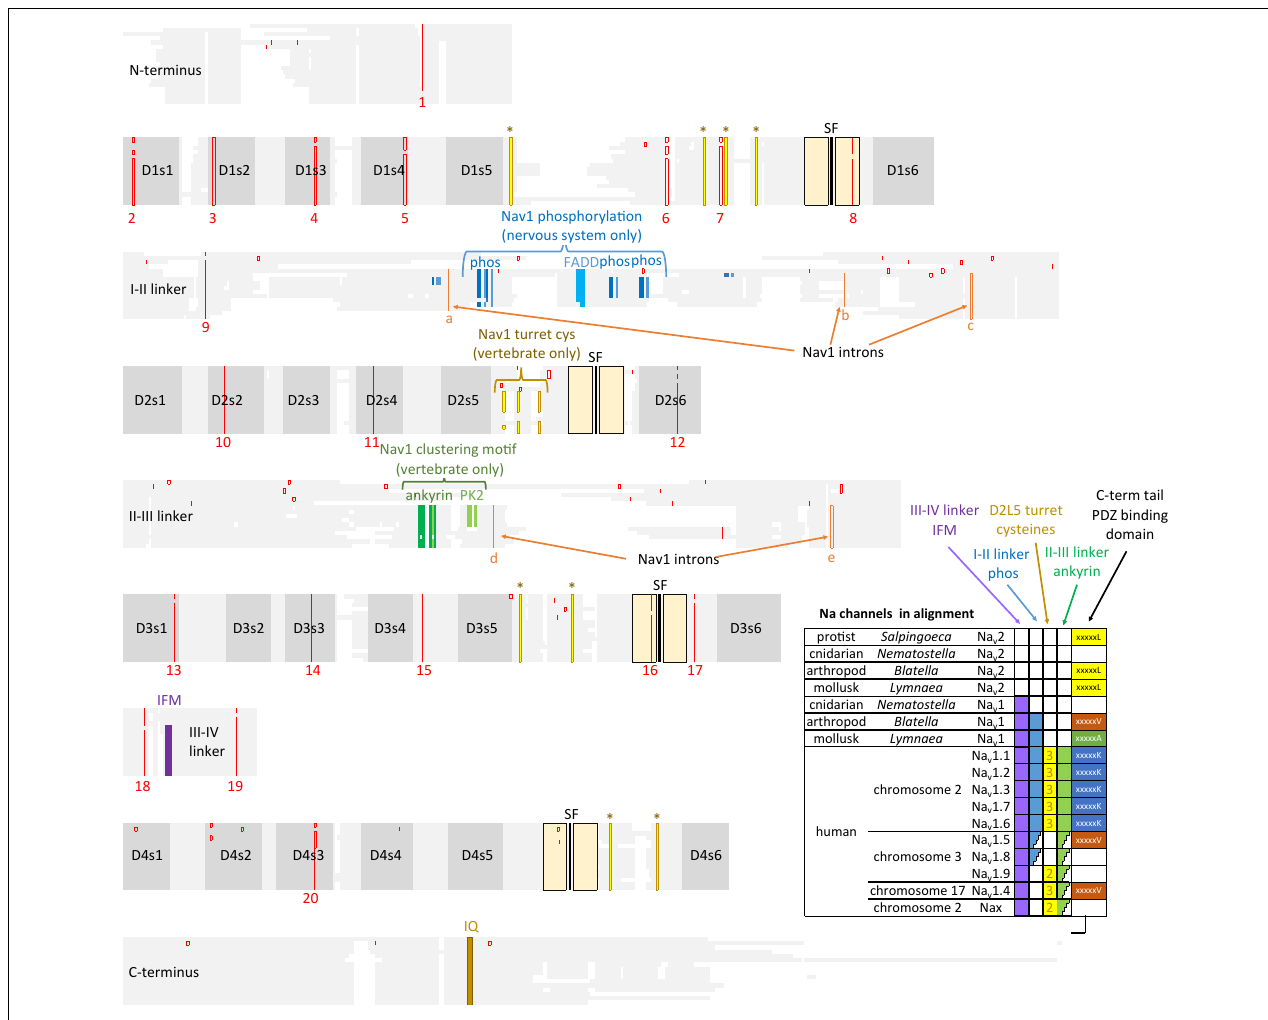
FIGURE 10 | Amino acid alignments illustrating the conservation of twenty intron splice sites (red vertical lines) shared between Na v 2 channels and Na v 1 channels. The close kinship between the Na v 2 channel class only found in non-vertebrates and the classical Na v 1 channels is evident in the shared genomic structure. Na v 1 differ primarily from Na v 2 channels in containing three additional intron splice sites (a–c) in the I-II linker and two splice sites (d,e) in the II-III linker. Extra exons in the I-II linker provides exons coding for conserved phosphorylation sites within invertebrate Na v 1 and vertebrate homologs (Na v 1.1, 1.2, 1.3, 1.6, and 1.7) expressed in central nervous systems. Vertebrate, but not invertebrate Na v 1 channel homologs contain three extra L5 II turret cysteines, and an ankyrin binding site that contribute to the localized clustering of Na v 1 channels in vertebrate Axon Initial Segments and nodes of Ranvier (Hill et al., 2008). Na v 1 channels possess an IFM motif and surrounding residues within the III-IV linker which contribute to the fast inactivation (West et al., 1992). Na v 2 and Na v 1 channels possess a conserved proximal C-terminus containing an IQ motif required for calmodulin binding (Ben-Johny et al., 2014, 2015). Different C-terminal motifs containing PDZ binding domains are possessed in sodium channels. Amino acid sequences were aligned using MUSCLE 3.7 (Edgar, 2004) within EMBL-EBI web interface (Chojnacki et al.,